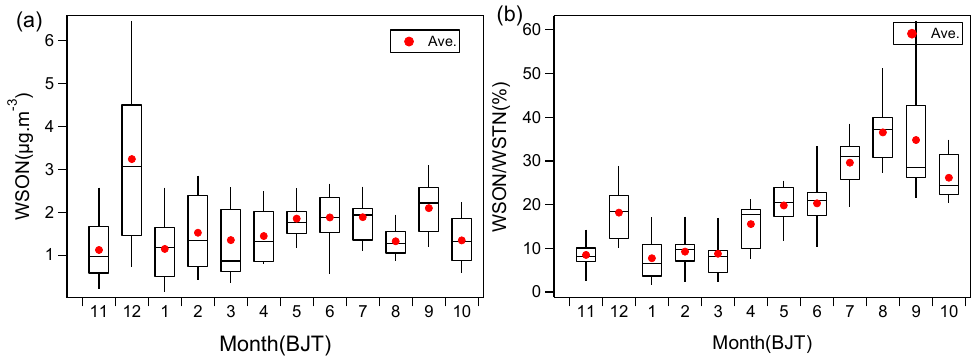
Figure 8. Monthly average concentrations of WSON ( a ), and WSON/WSTN (%) ( b ).